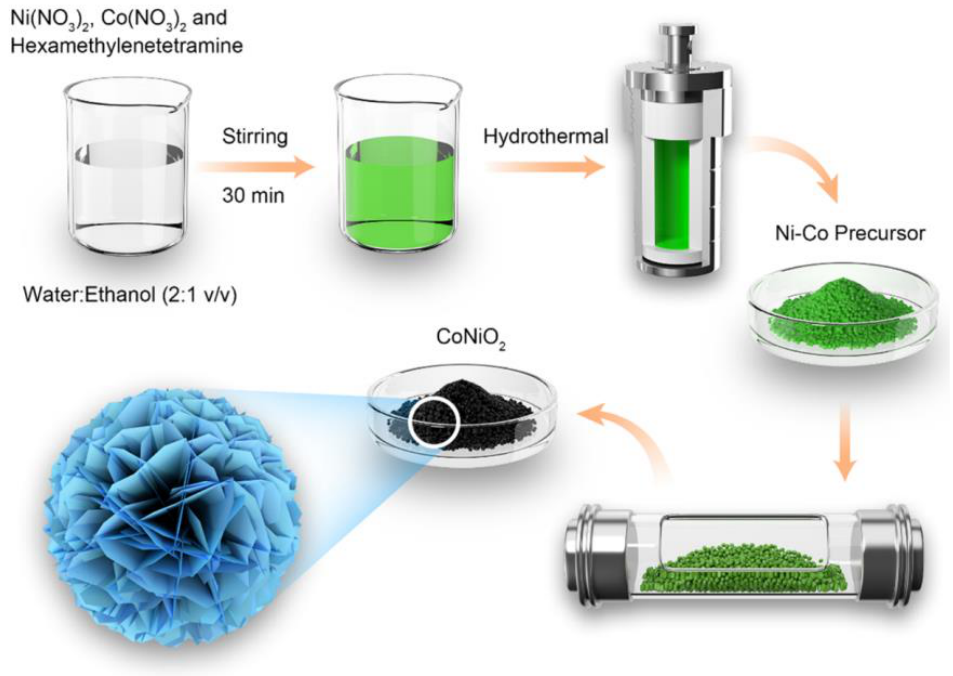
Figure 1. The fabrication procedure is illustrated in this schematic diagram for hierarchical CoNiO 2 microflowers assembled by mesoporous nanosheets. To investigate the crystal structure of the electrocatalyst, an XRD analysis has been car- ried out. The characteristic peaks of CoNiO 2 in Figure 2 located at 36.8 ◦ , 42.8 ◦ and 61.8 ◦ cor- respond to the (111), (200) and (220) planes of the cubic CoNiO 2 (JCPDS No. 10-0188) [25,26]. Meanwhile, the (111), (200) and (220) planes of metallic Ni can be matched to the diffraction peaks of Ni specimens at 44.5 ◦ , 51.8 ◦ and 76.4 ◦ (JCPDS No.04-0850) [27]. The characteristic peaks of the Co sample located at 41.7 ◦ , 44.7 ◦ , 47.6 ◦ and 75.9 ◦ are associated to the (100), (002), (101) and (110) of the metallic Cobalt’s planes (JCPDS No. 05-0727) [28]. It was observed that there were no significant peaks of impurities, which indicated that the products were phase pure. Particularly, compared with the single metallic Ni or Co specimen, CoNiO 2 presents the weaker peak intensities. The relatively poor crystallinity means that CoNiO 2 exhibits the thinner thickness and higher defects concentration, which is expected to show better activity in the hydrogen evolution